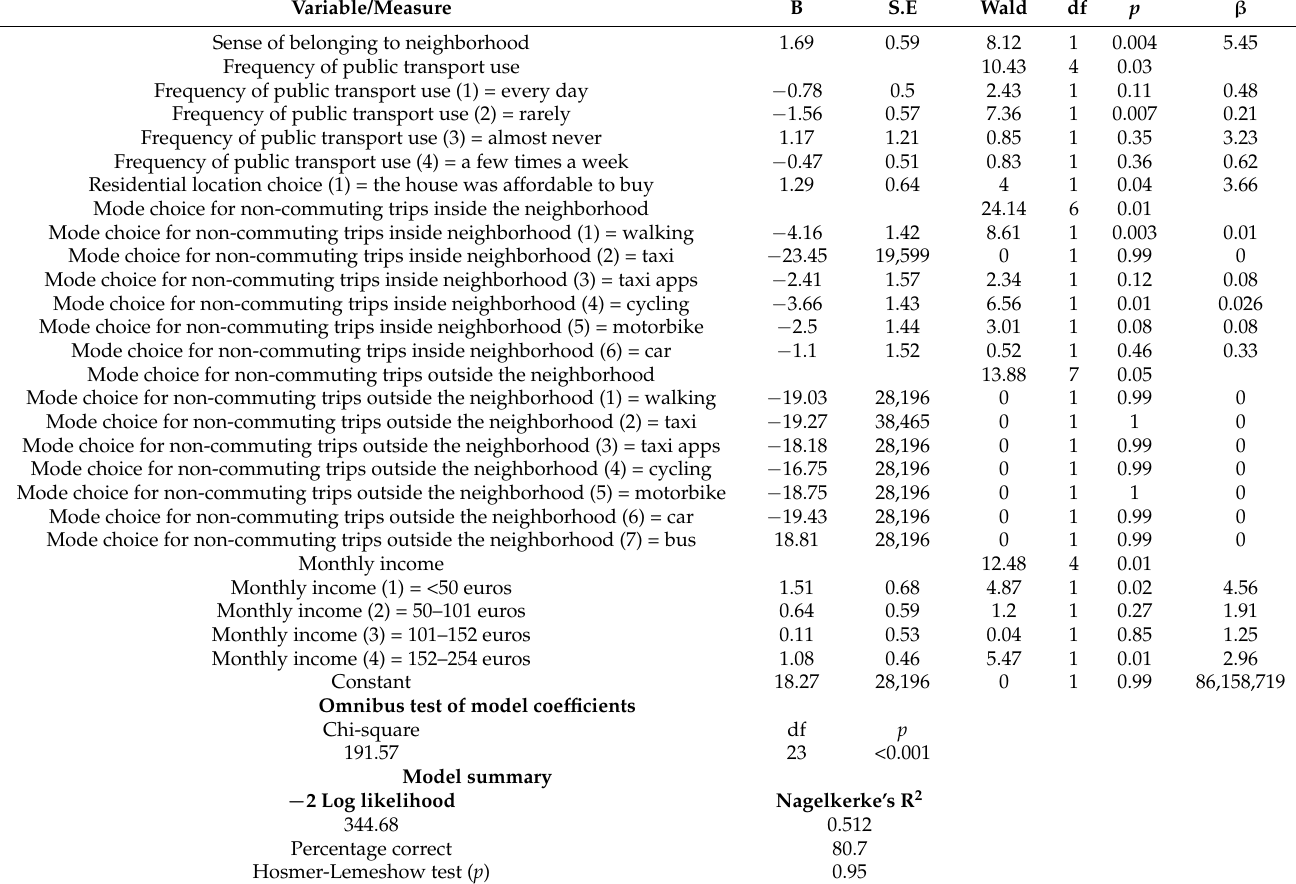
Table 5. Binary logistic model for choice of destination of shopping trips for residents in compact districts. Variable/Measure B Sense of belonging to neighborhood